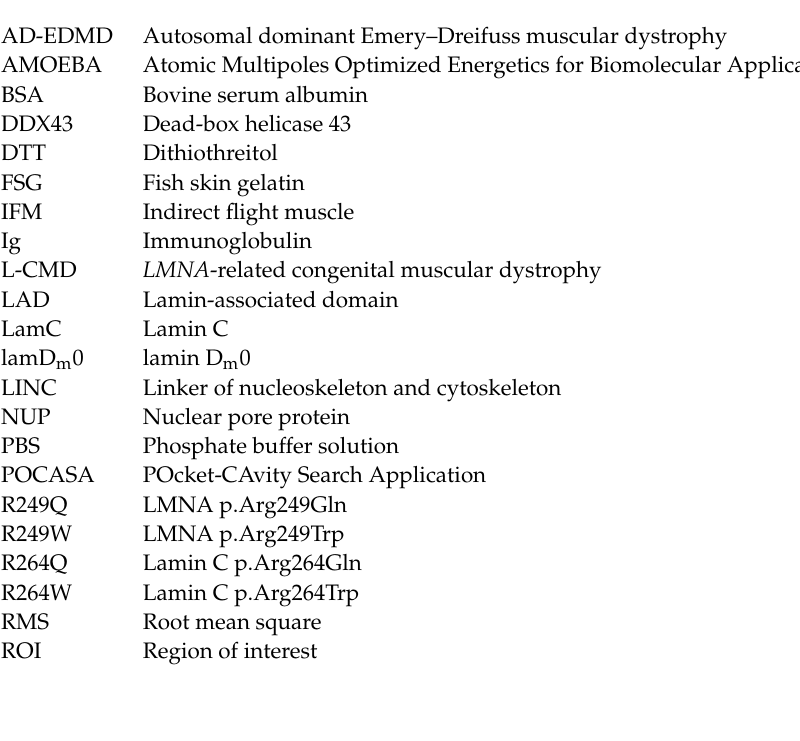
Table S2: Predicted protein interaction pockets in the lamin A/C Ig-like fold domain possess amino acids that are necessary for partner protein interactions, Supplementary Table S3: Abnormal wing pos-turing caused by R264Q/W was